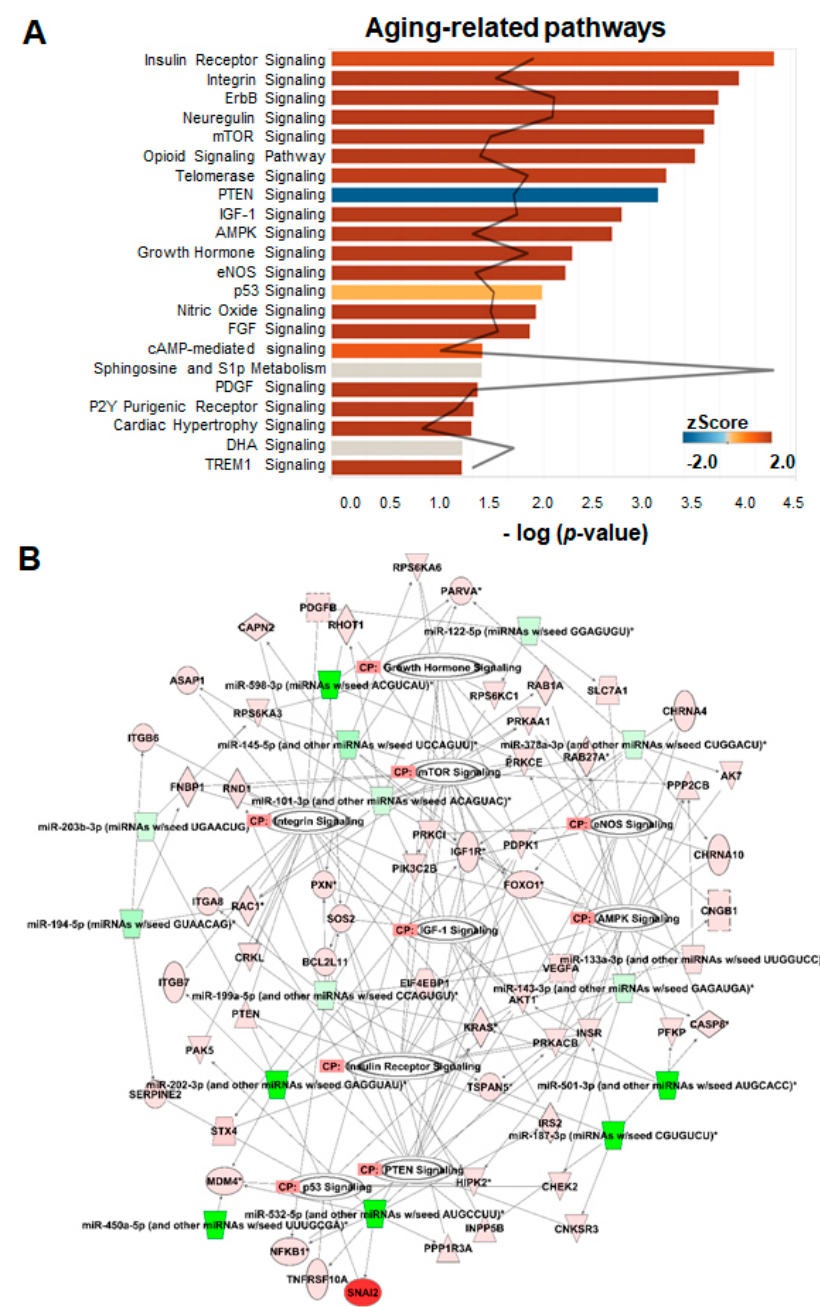
Figure 5. Ingenuity Pathway Analysis (IPA) of the di ff erentially expressed miRNAs in serum exosomes from young and old rats. ( A ) IPA showing the 22 most significant aging-related pathways involving mRNAs, whose expression is regulated by di ff erentially expressed miRNAs in serum exosomes from young and old rats. Each Z score represents the upregulation or downregulation of gene expression based on young vs. old. The black curve denotes the ratio between the number of the di ff erentially expressed target genes and the total number of genes in each of these pathways. ( B ) IPA-predicted network for the di ff erentially expressed miRNAs showing predicted targets and their association with biological functions in aging-related signaling pathways governed by the following factors: growth hormone signaling, mammalian target of rapamycin (mTOR) signaling, endothelial nitric oxide synthase (eNOS) signaling, integrin signaling, insulin-like growth factor-1 (IGF-1) signaling, AMP-activated protein kinase (AMPK) signaling, insulin receptor signaling, p53 signaling, and phosphatase and tensin homolog 10 (PTEN) signaling.